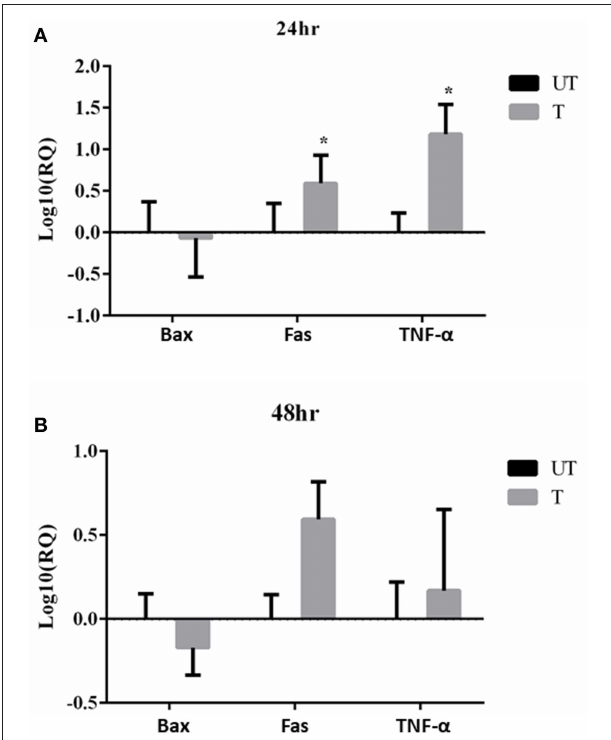
FIGURE 8 | Effects of rfhSP-D treated SKOV3 cells on Bax, Fas and TNF- α at 24h (A) and 48h (B) . Fas and TNF- α are significantly up-regulated at 24h of treatment compared to controls * P <